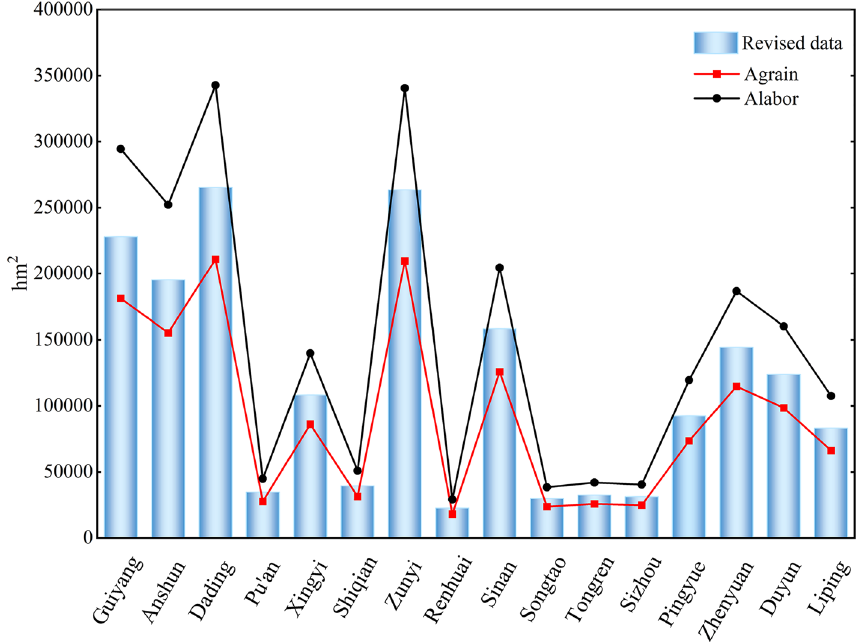
Figure 2. Results of Cropland data